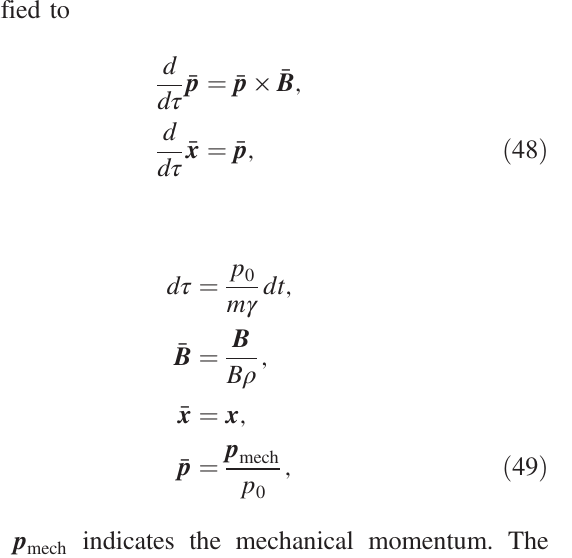
for the dipole entrance. co